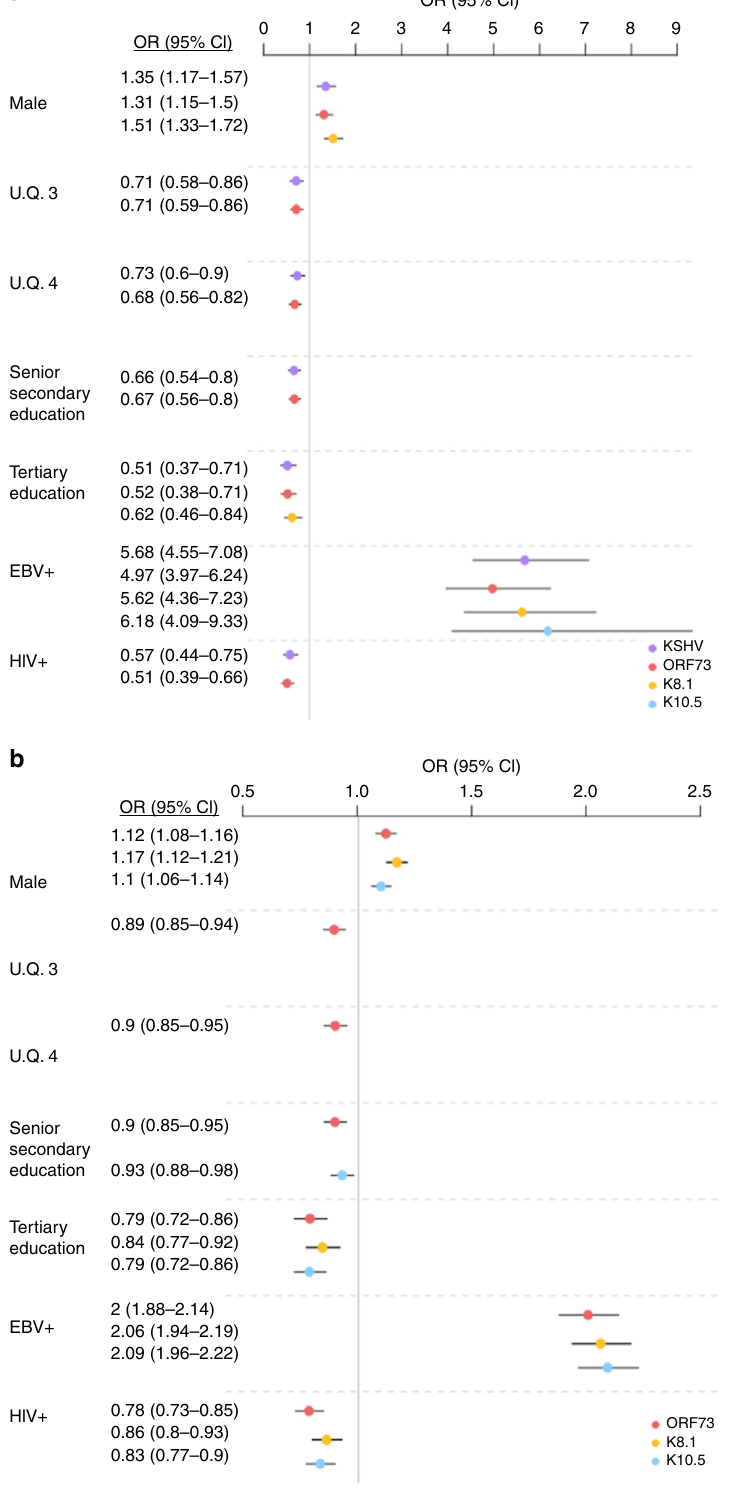
Fig. 2 Predictors of KSHV IgG antibody response. Odds ratios (ORs) and 95% con fi dence intervals (CI) of signi fi cant associations ( p < 0.006) between factors and IgG variable as determined based on serologies in the 4365 individuals from the GPC. a Predictors of IgG serostatus. ORs and 95% CI were estimated following a multivariate logistic regression analysis with serostatus (seropositive vs seronegative) as response variable. b Predictors of IgG response level. ORs and 95% CI were estimated following a multivariate linear regression analysis with log 10 -transformed MFI as response variable. UQ urbanicity quartile. Dots represent the ORs and are coloured by IgG variable: KSHV (seropositivity to any antigen) — purple, ORF73 — red, K8.1 — yellow, K10.5 — light blue; lines represent the 95% con fi dence intervals. Full results from this analysis are provided in Supplementary Data